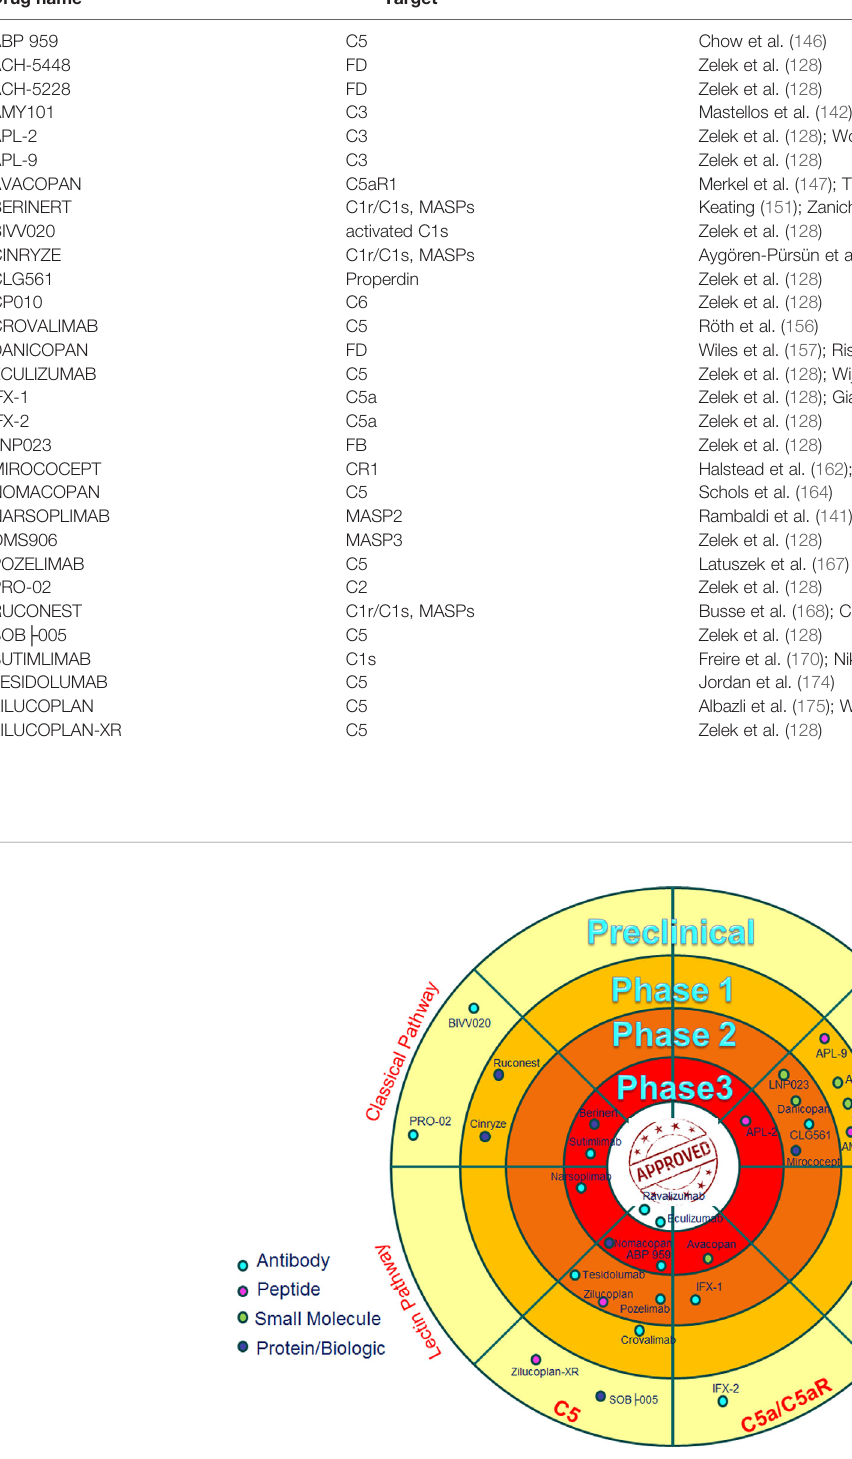
FIGURE 4 | Anti-complement drugs currently in clinical development. The dartboard with concentric rings indicates the different phases of clinical development, with “ approved ” in the centre. Only drugs currently in clinical development are shown and the most advanced stage of development for any indication is shown. The drugs are divided on the basis of the target (Classical, Lectin and Alternative Pathways), with the exception of some drugs that are directed to the common part of the three cascades (C5 and MAC), or drugs that are speci fi cally blocking C5a activity (C5a/C5aR)